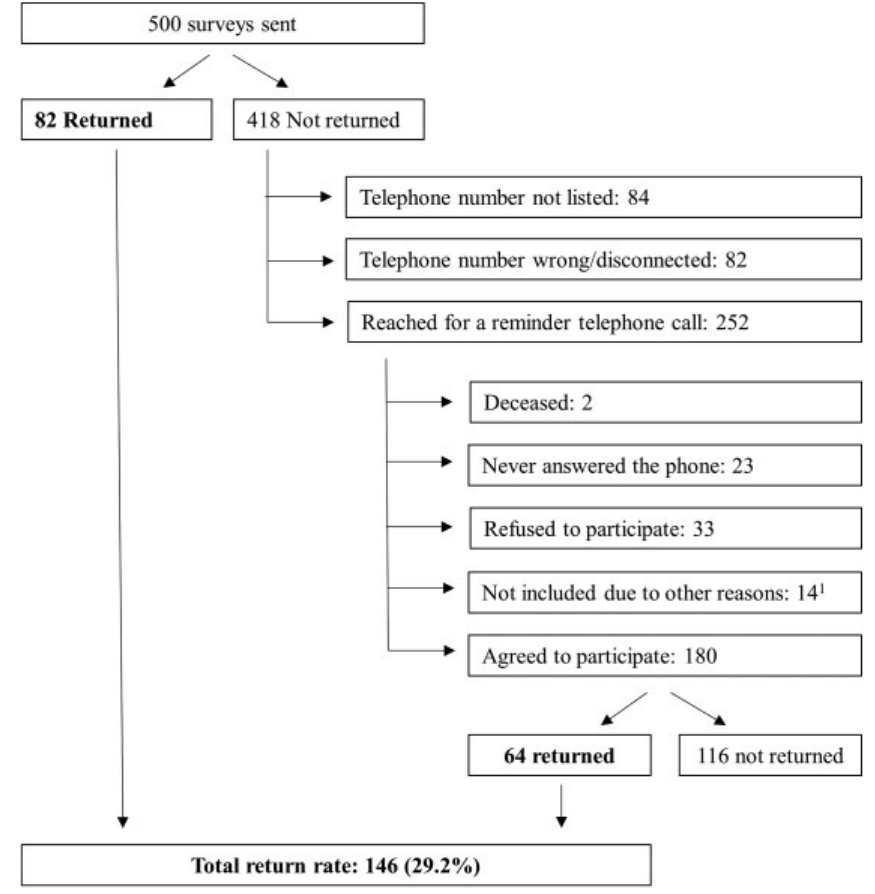
Fig. 1 Flowchart of study participants and reasons for nonparticipation. 1 Other reasons for nonparticipation included living abroad ( n ¼ 6), unable to answer due to other comorbidities (blindness, cerebral palsy, and cognitive impairment) ( n ¼ 3), bad phone reception despite several calls ( n ¼ 3), and increased factor activity level ( > 40%) due to liver transplant ( n ¼